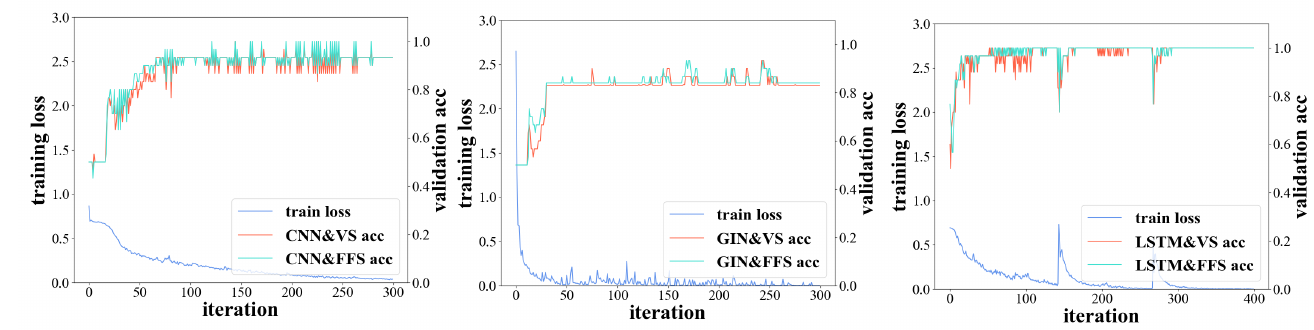
Figure 3. Losses of the training sets for deep learning models and classification accuracies of test sets for different